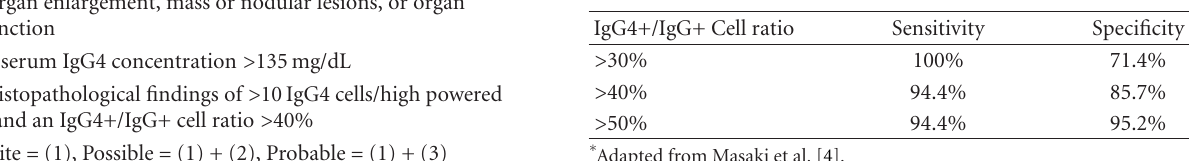
Table 2: Proposed comprehensive diagnostic criteria for IgG4-RD ∗ . Table 3: Specificity and sensitivity of IgG4+/IgG+ cell ratio for diagnosis of IgG4-RD ∗